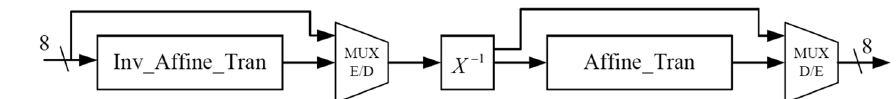
Fig. 9 S-Box operation in composite field GF((2 4 ) 2 ) for encryption and